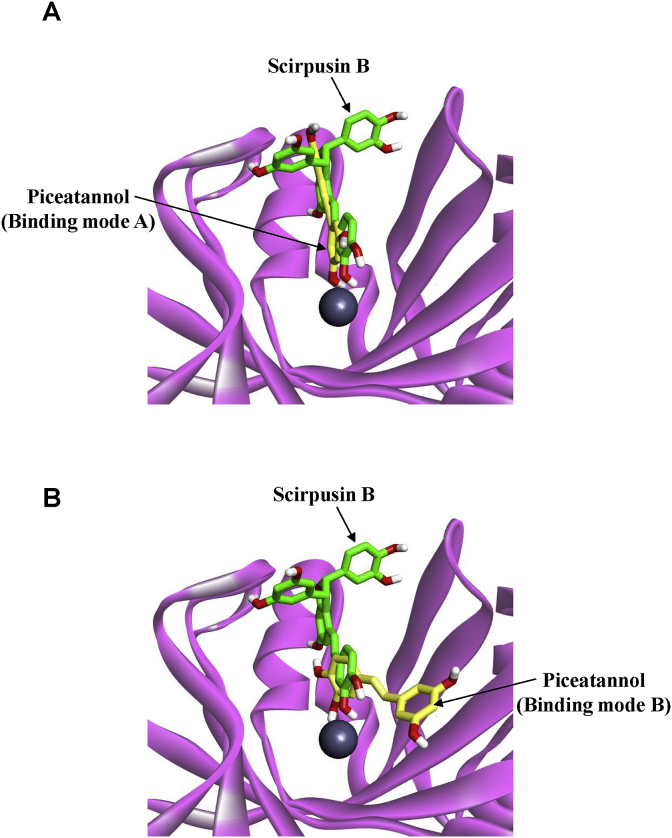
The predicted binding modes of piceatannol or scirpusin B against human GLO I. The ribbons (pink) represent the active site of human GLO I. Carbon and oxygen atoms of piceatannol or scirpusin B are illustrated in green and red sticks. Binding mode A: the predicted binding mode of piceatannol similar to that of baicalein (yellow stick). (A) The predicted binding modes of piceatannol/human GLO I. (B) The predicted binding modes of scirpusin B/human GLO I.